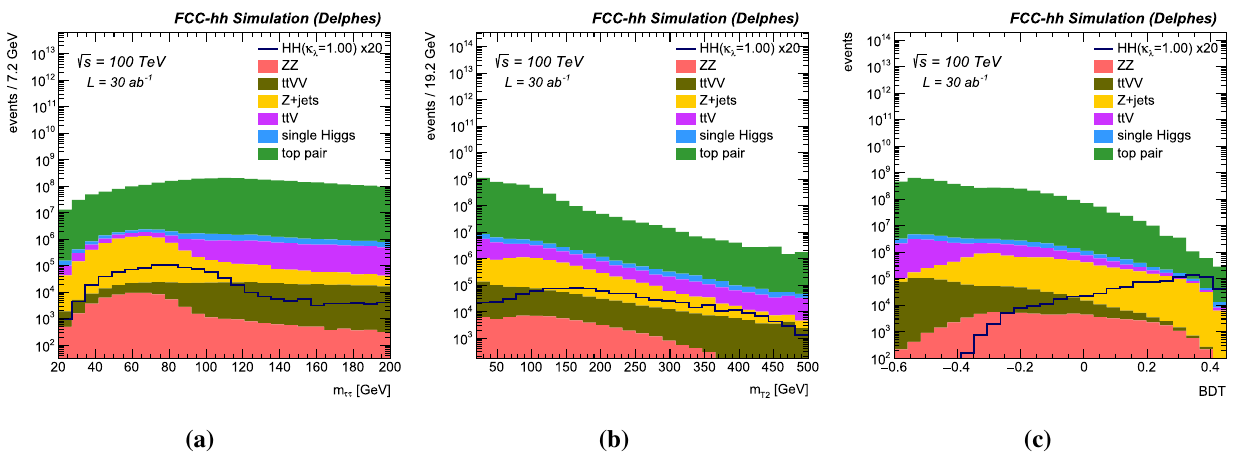
Fig. 9 Distributions in the b ¯ b τ h τ (cid:10) final state of the invariant mass of the ττ pair (left), m T2 (center), and output of the BDT multi-variate discriminant